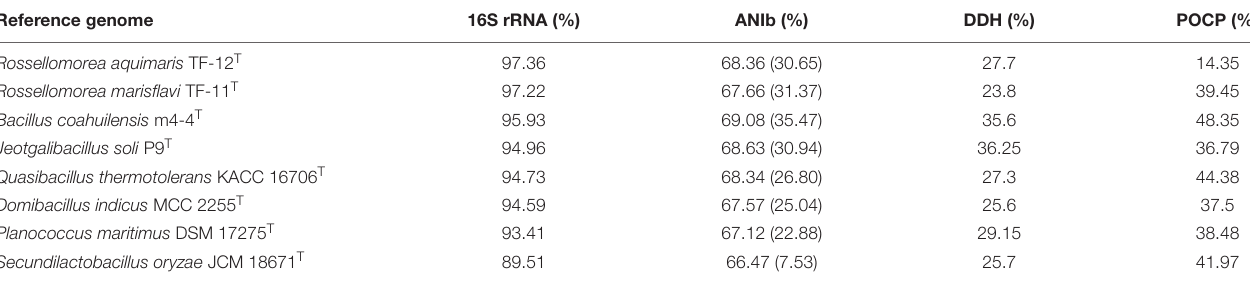
TABLE 1 | Percentage identity of 16S rRNA gene comparisons, Average Nucleotide Identity via BLAST (ANIb), and percentage of aligned sequences in brackets, digital DNA–DNA hybridization (DDH), and percentage of conserved proteins (POCP) matrix of our isolate R1DC41 T and other closely related species belonging to the Bacillaceae , Lactobacillaceae , and Planococcaceae ; the full list of closest related analyzed for each genus is reported in Supplementary Table 2 . Reference